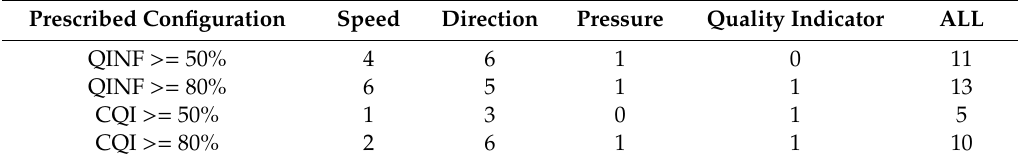
Table 18. Similarities found in the AMV datasets by the ‘paired t-test’ for the di ff erent combinations of variables and AMV datasets, in Experiment 1 (with prescribed configuration).